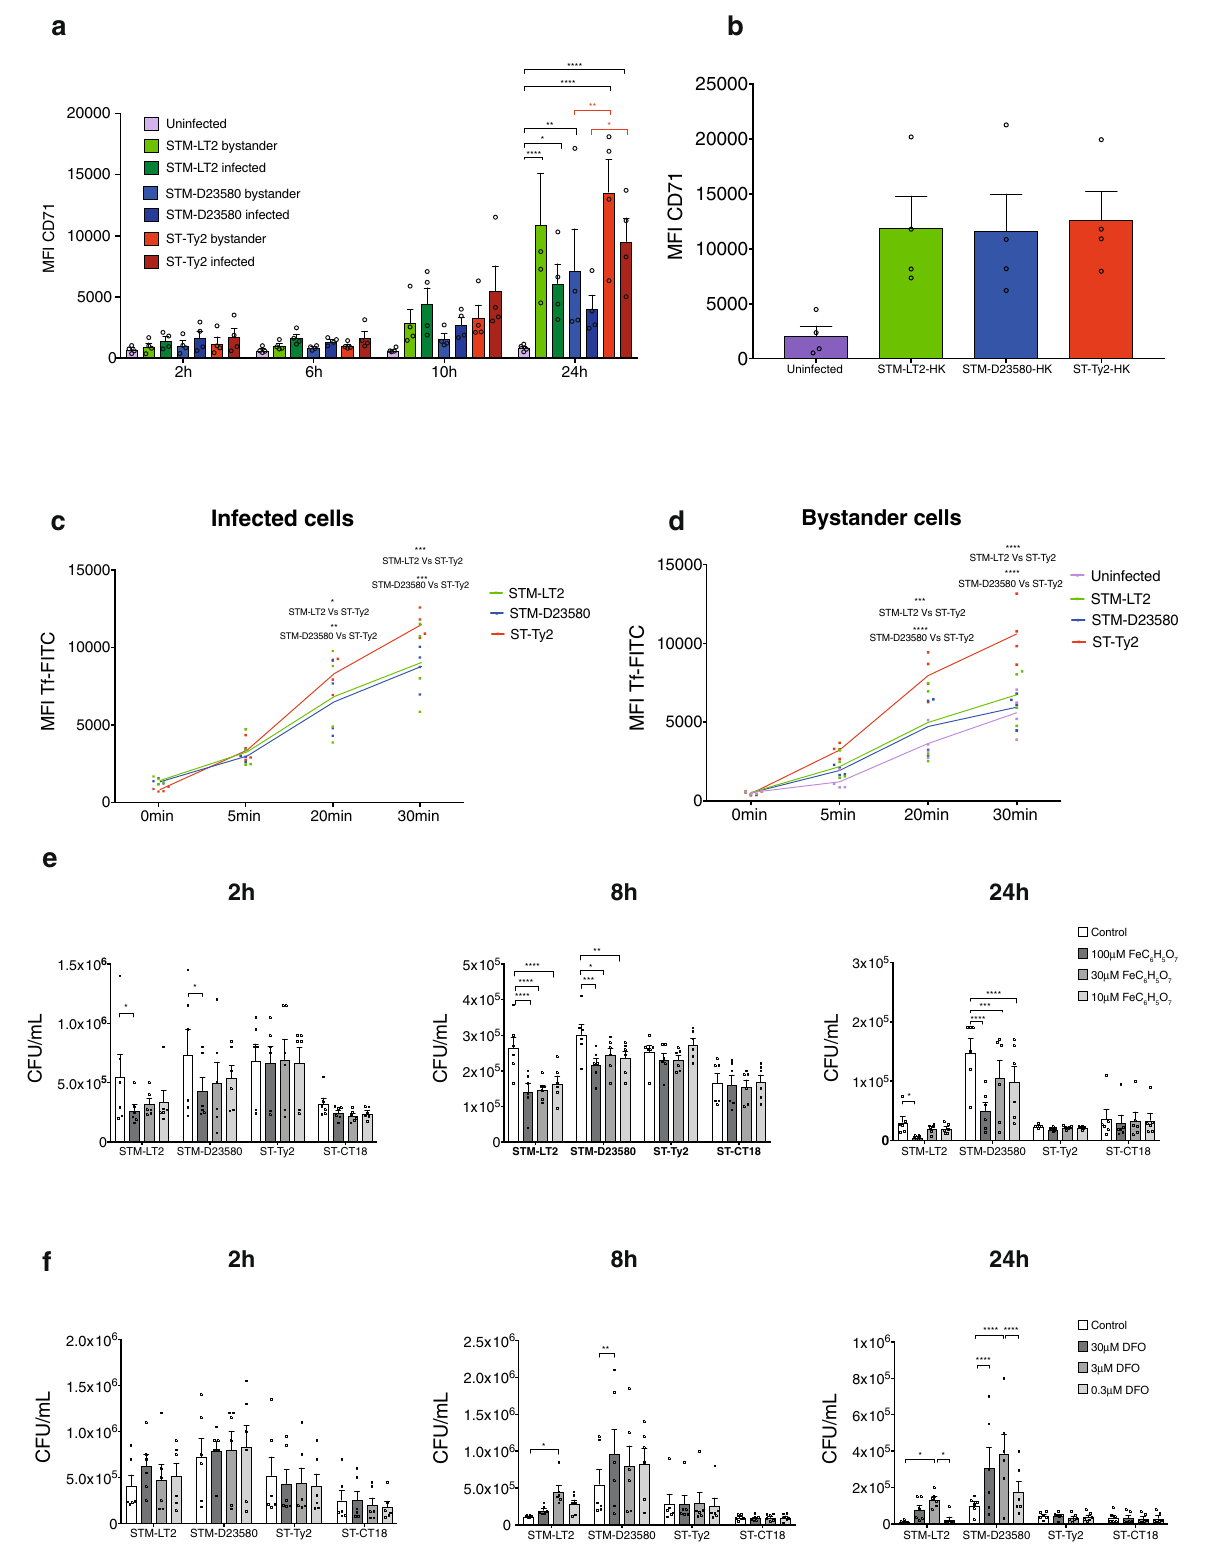
Transcriptional rewiring of S . Typhi in response to intracel- lular ROI and RNI . Inside the Salmonella containing vacuole (SCV) Salmonella is exposed to several stressors, including increased levels of ROI and RNI. The ability of myeloid cells to increase ROI and RNI production is an important defence mechanism by which intracellular Salmonella infection is